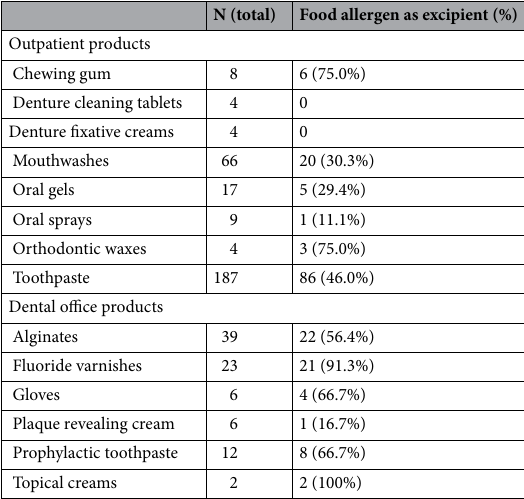
Table 1. Prevalence of food allergens in the labeling.